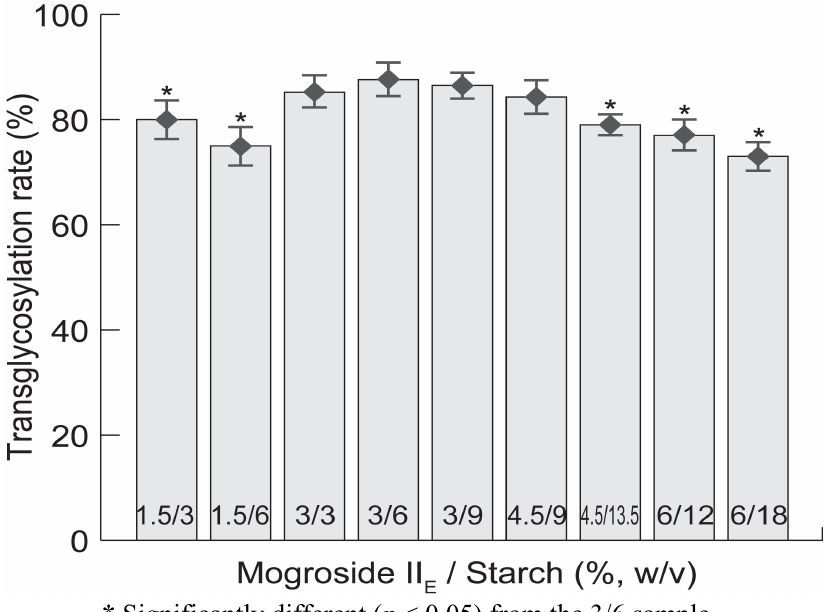
* Significantly different ( p < 0.05) from the 3/6